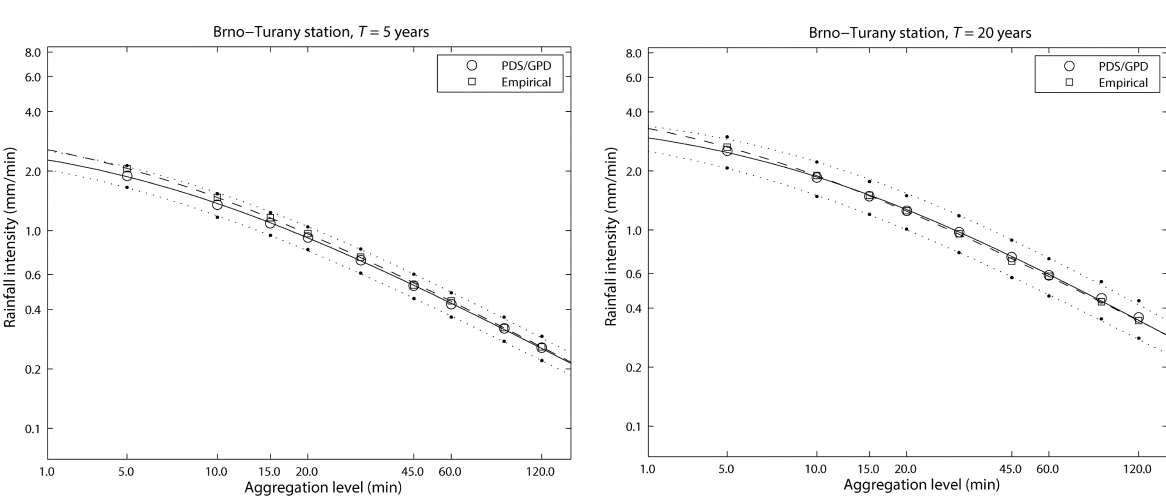
Fig. 10. Comparison of IDF curves (Data 2) calculated using the GP distribution from Data 2 (95% confidence intervals are denoted by dotted lines) with those evaluated empirically from Data 1; logarithmic scales on both